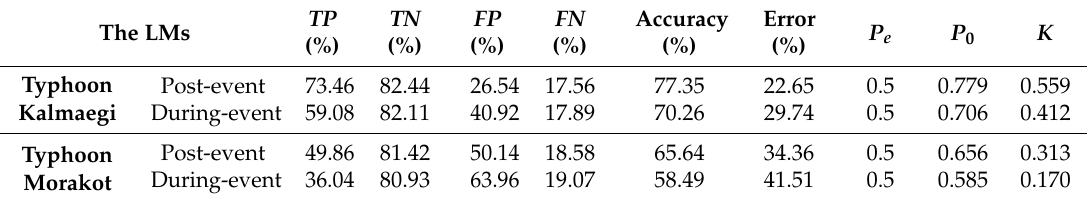
Table 7. A statistical table of validating results (Typhoon Kalmaegi and Typhoon